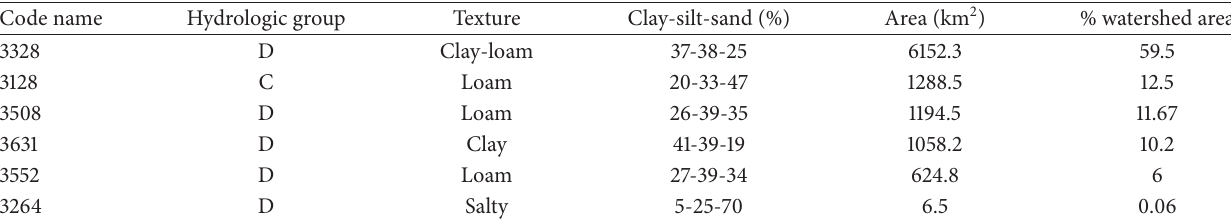
Table 1: General soil features of Roodan